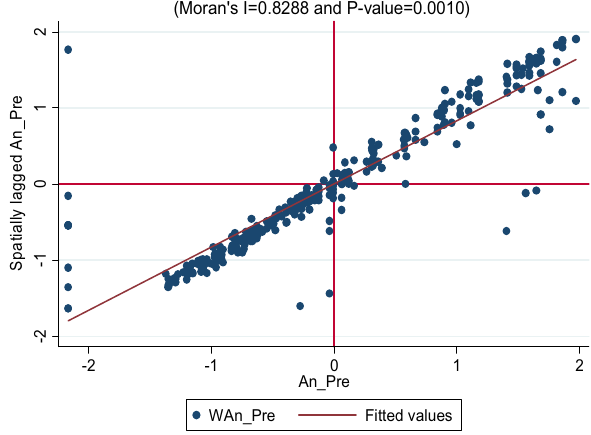
Figure 2. Moran’s I scatter plot for annual precipitation.